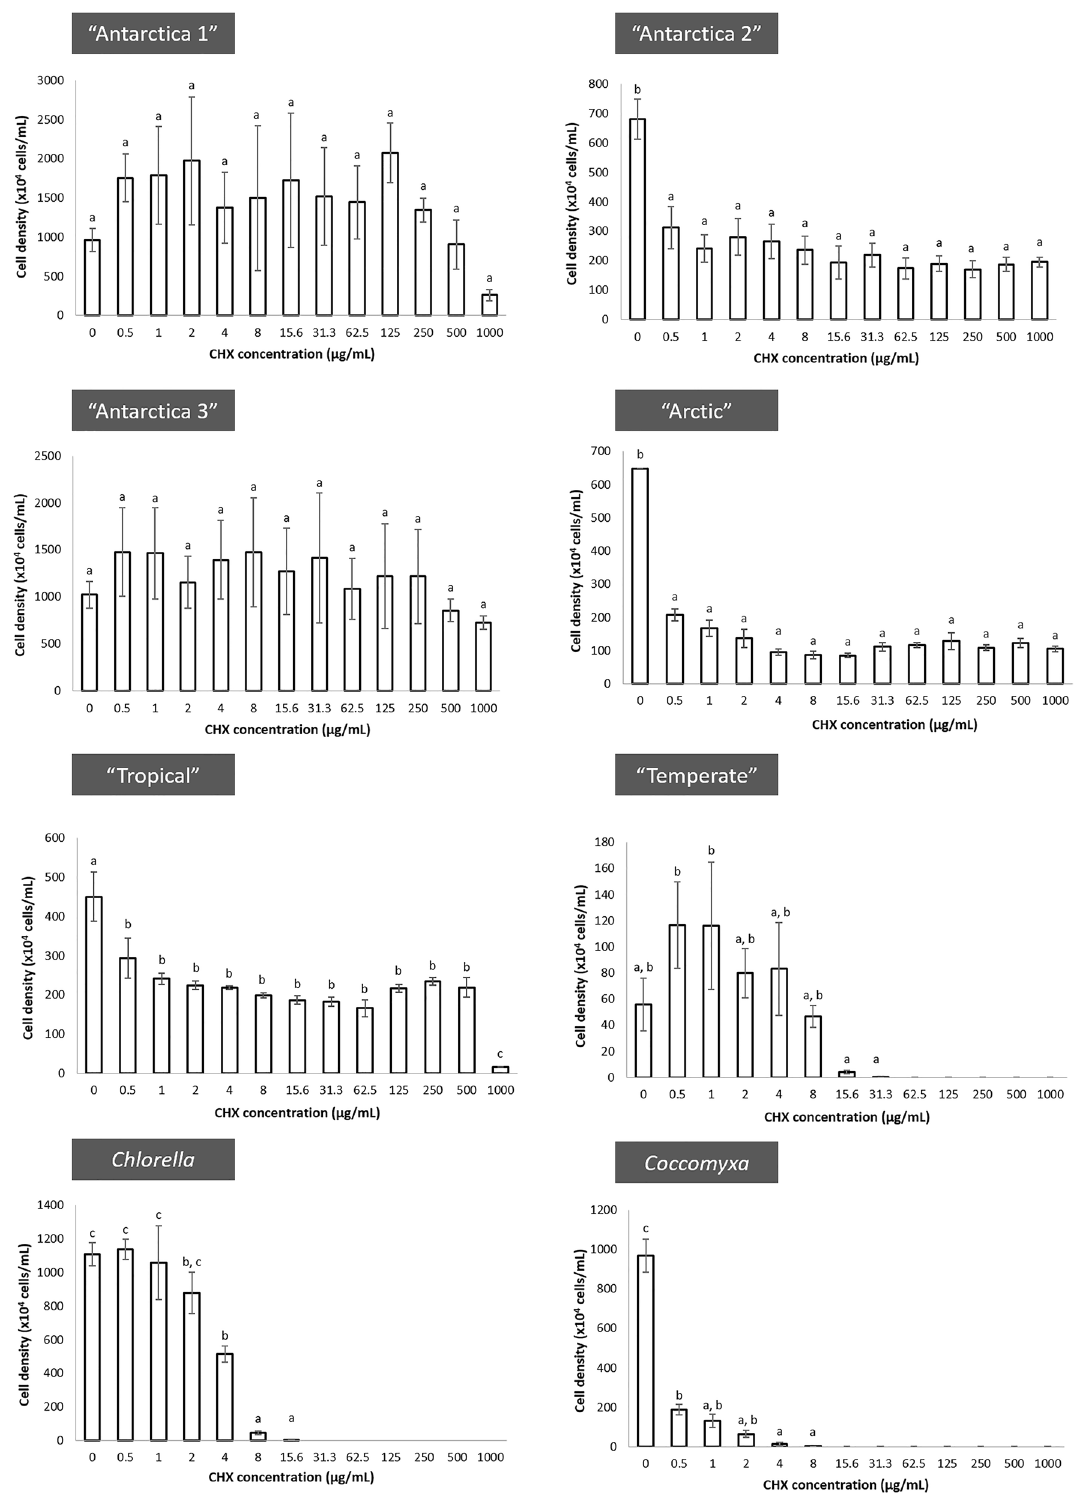
Figure 1. Mean (± standard error) of cell density achieved by each of six strains of Stichococcus -like algae and single strains of Chlorella and Coccomyxa in BBM liquid medium supplemented with different CHX concentrations after two weeks’ incubation. Means sharing the same letter (a, b or c) are not significantly different (Tukey’s HSD, p <